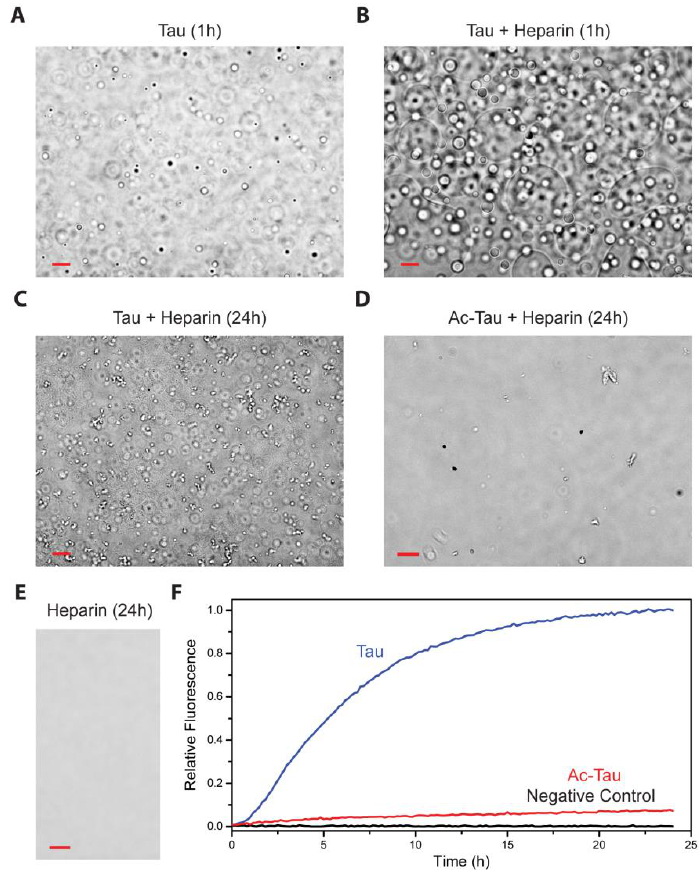
Figure 3. Acetylation disfavors heparin-induced Tau aggregation. ( A , B ) Heparin accelerates non-acetylated wt Tau LLPS. The presence of heparin (5 µM heparin: 20 µM Tau ratio) results in non-acetylated wt Tau LLPS. The presence of heparin (5 µ M heparin: 20 µ M Tau ratio) results in for Ac-Tau in the absence (Figure 2B,D) or presence of heparin (24 h, ( D )). After 24 h incubation, ( C , D ). No aggregation/LLPS was observed for the heparin control ( E ). Ac-Tau displayed minimal aggregation compared to wt Tau as reported by Th T fluorescence assay ( F ). Scale bars represent 10 µ m. See Section 3 for